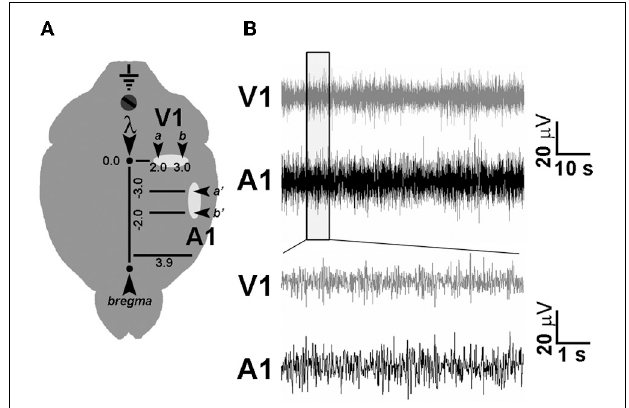
FIGURE 2 | Chronic electrode implant for LFP recordings. (A) Schematic diagram showing electrode placement for LFP recording in V1 and A1. A couple of nichrome wire electrodes (arrowheads) were placed in each cortical area at the indicated stereotaxic coordinates to perform differential electrophysiological recordings. (B) Representative LFP traces recorded using chronic electrode implants in freely moving, awake